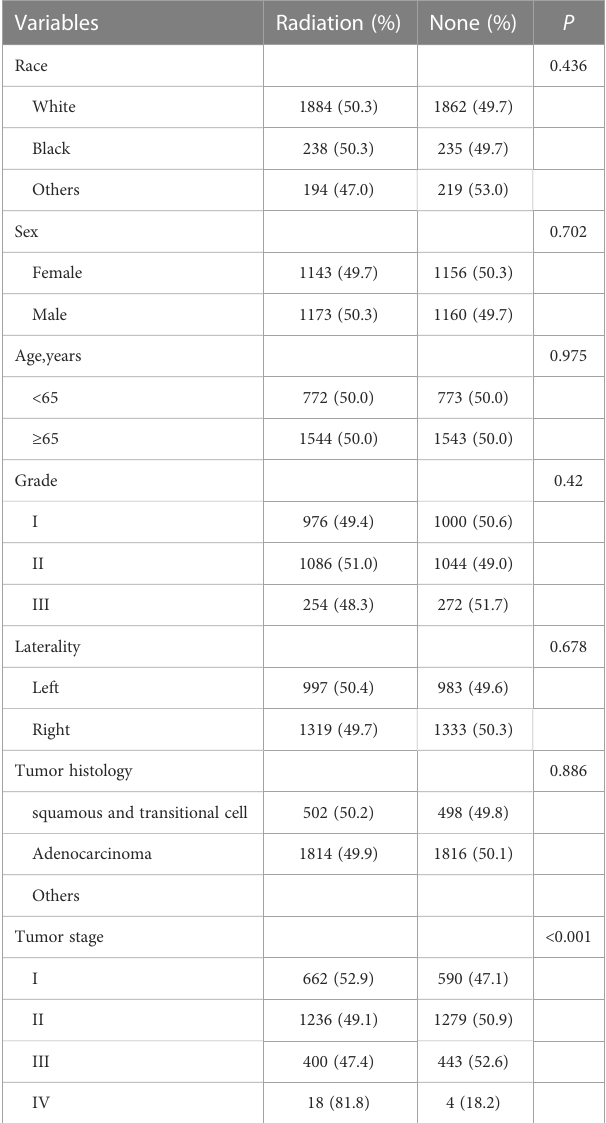
TABLE 1A Baseline Characteristics of Patients with IIIA-N2 NSCLC of OS.